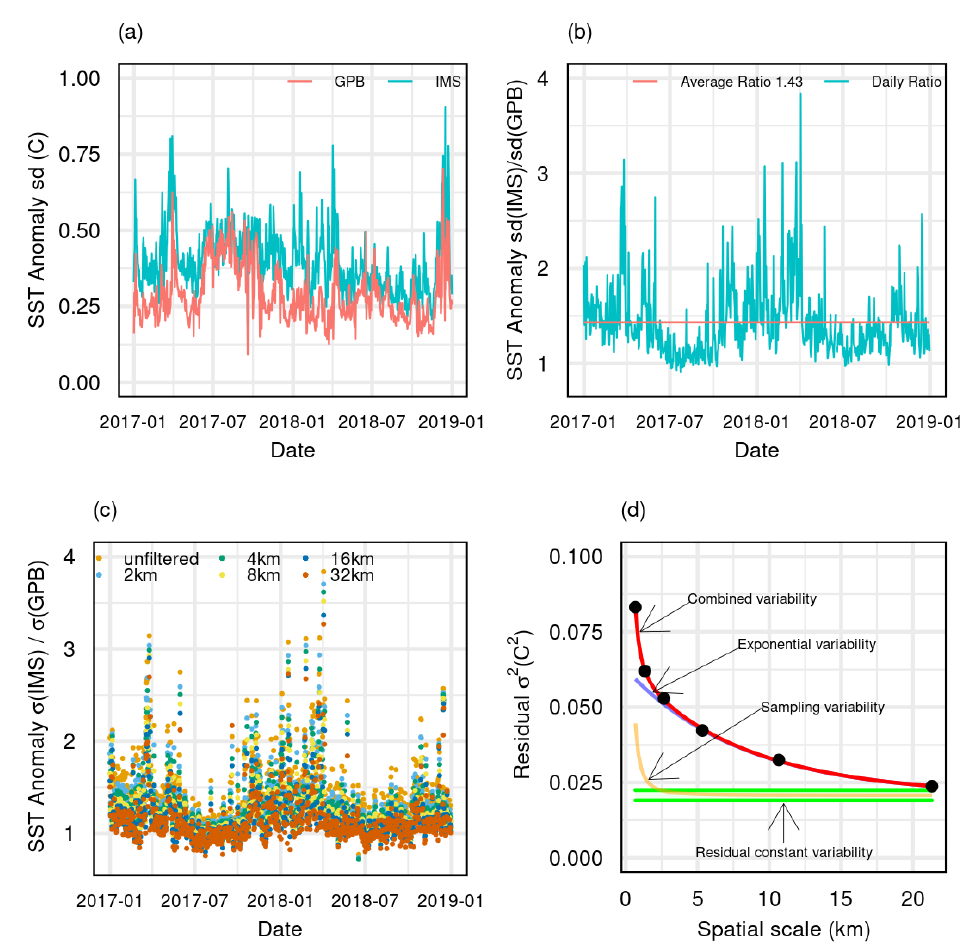
Figure 11. A comparison of IMOS Multi-sensor L3S and Geo-Polar Blended L4 with attributions of variability over GBR Marine Park. SST Anomaly (SST-SSTAARS) ( a ) standard deviation variation variability, ( b ) standard deviation ratio, ( c ) variability ratio with different filter radii and ( d ) allocation of residual variability. Where the red line denotes combined variability, the blue line denotes exponential variability (0.042 ± 0.004C 2 ) on a ≈ 8 km scale and the orange line denotes sampling variability ≈ ( 0.04 ± 0.02 C 2 ) /(sample size), where these all add to the green line denoting a residual constant variability (skin to depth variability) of ≈ 0.021 ± 0.002 C 2 . Data were sourced from